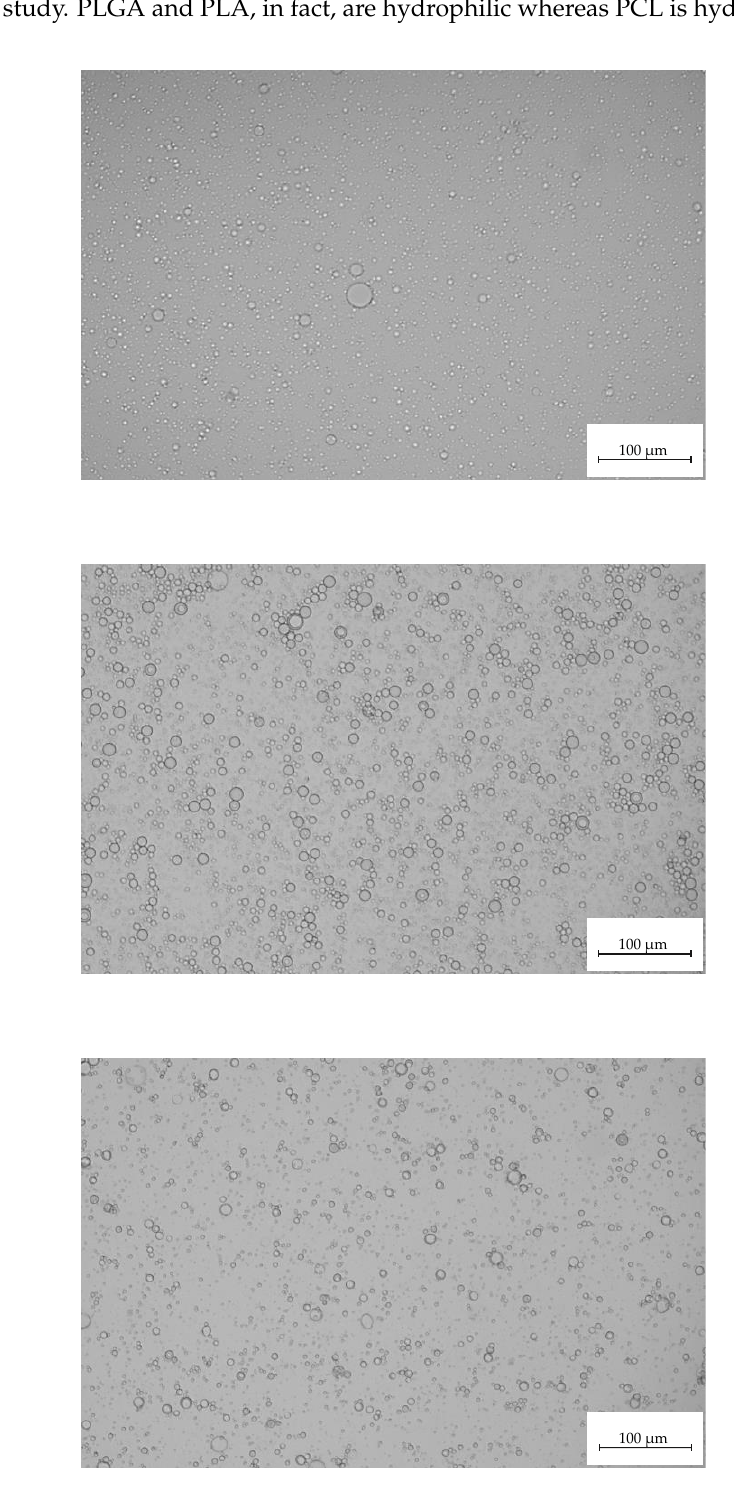
Figure 2. Representative optical microscope images of emulsions produced with the different poly- mers. PLGA: poly(lactic- co - glycolic acid), PCL: poly(ε -caprolactone), PLA: poly(lactic acid). After solvent evaporation, the MPs were characterized in terms of DMD, EE, and PMD. Results are summarized in Table 1.